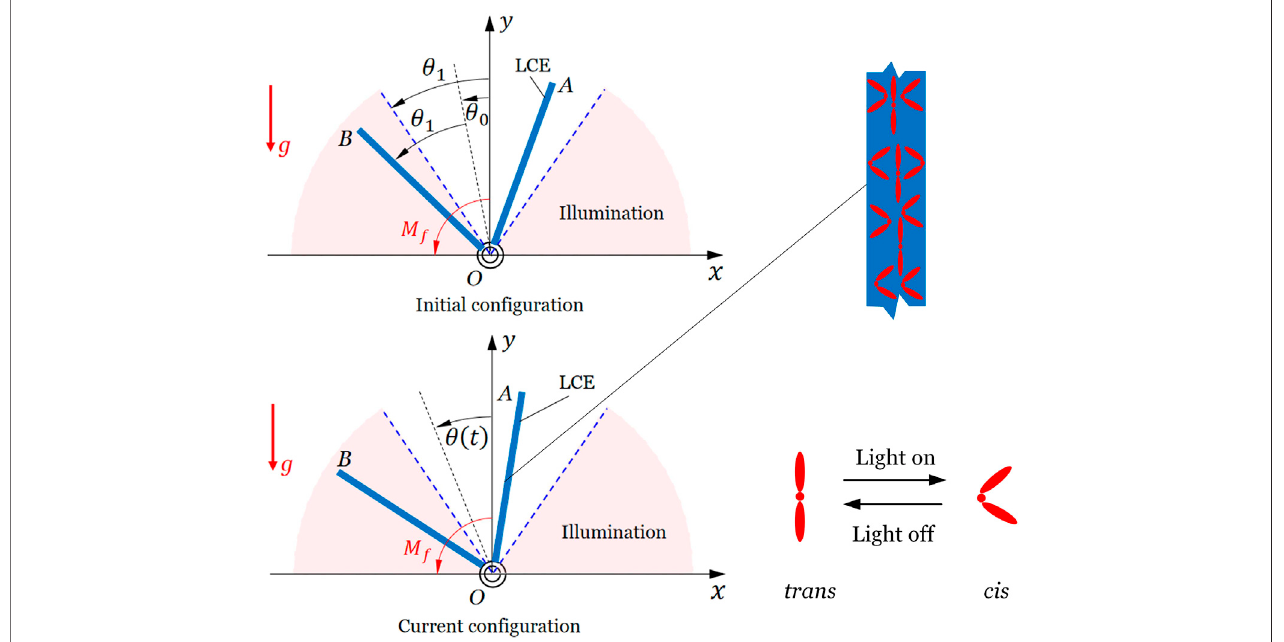
FIGURE1| SchematicofaninvertedpendulummadeupofaV-shapedopticallyresponsiveLCEbar.Understeadyillumination,theinvertedpendulumcanbeself- stabilized due to the reversal of gravity moment resulting from light-driven contraction of the LCE bars.